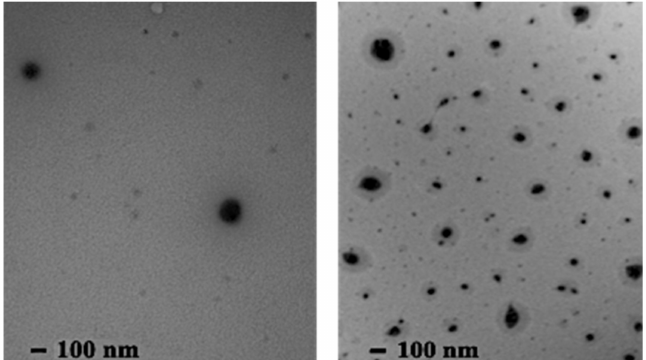
Figure 6. TEM pictures corresponding to the unmodified SNPs ( left ) and SNP- g -PMEO 2 MA (15%, DS 0.02, ( right )) stained with